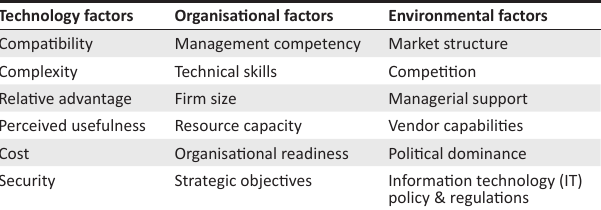
TABLE 1: Technology-organisational-environmental factors that influence blockchain